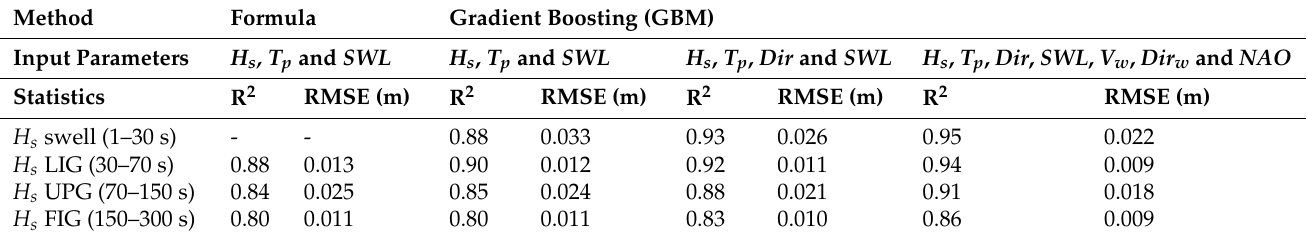
Table 3. Statistical comparison of forecast methods and input parameters for significant wave heights at the tide